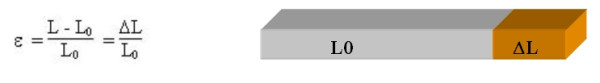
Calculation of deformation. Calculation of strain (ε), with L0 as the original length (grey bar in figure), ΔL the change in length (orange bar) and L as the total length (grey and orange bar).